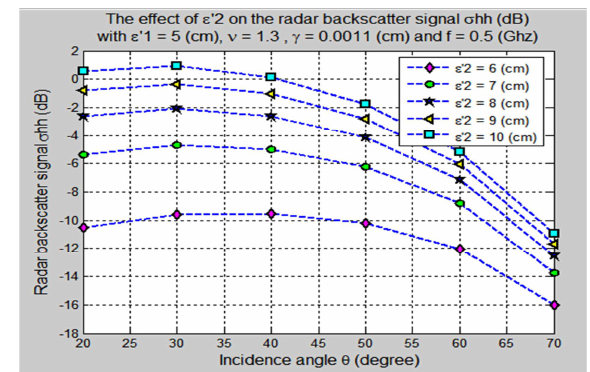
Figure 13. Backscattering coefficient dependence on ε ’ 2 at HH